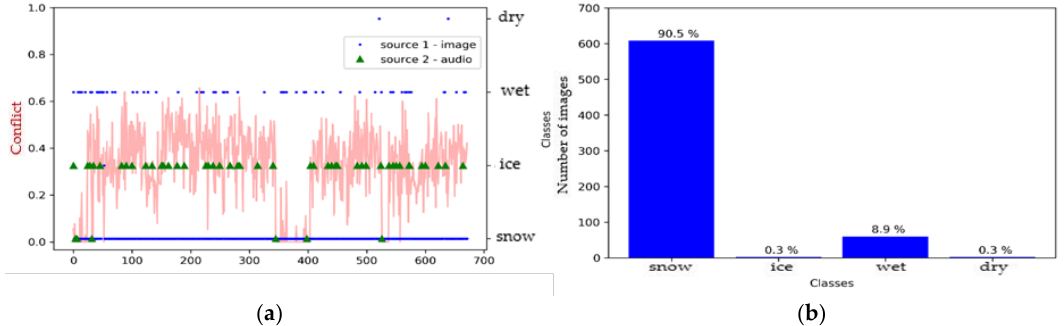
Figure 9. Environment #1. ( a ) Classification of sources with MobileNetV3_small (video) and M5 (audio) prior to fusion, together with conflict analysis; ( b ) histogram prior to image fusion.